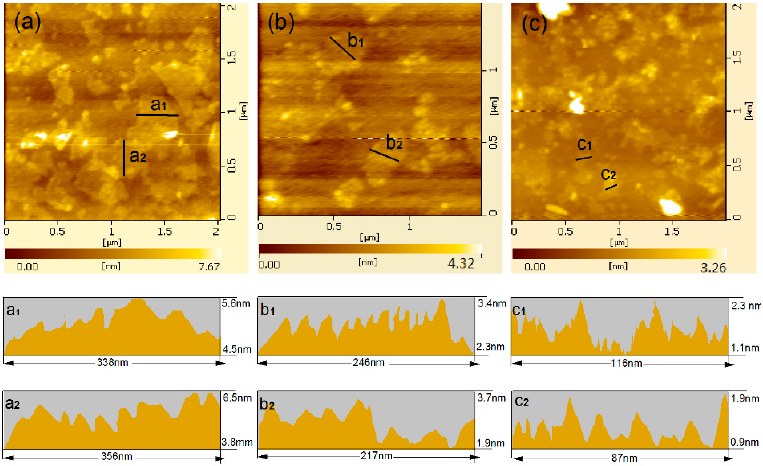
Figure 5. AFM images of GO nanosheets from ( a ) GO/PAM composites; ( b ) GO/PAH composites; and ( c ) GO/PAA composites. ( a 1 , a 2 , b 1 , b 2 , c 1 , c 2 ) are side views of GO at the corresponding lines.